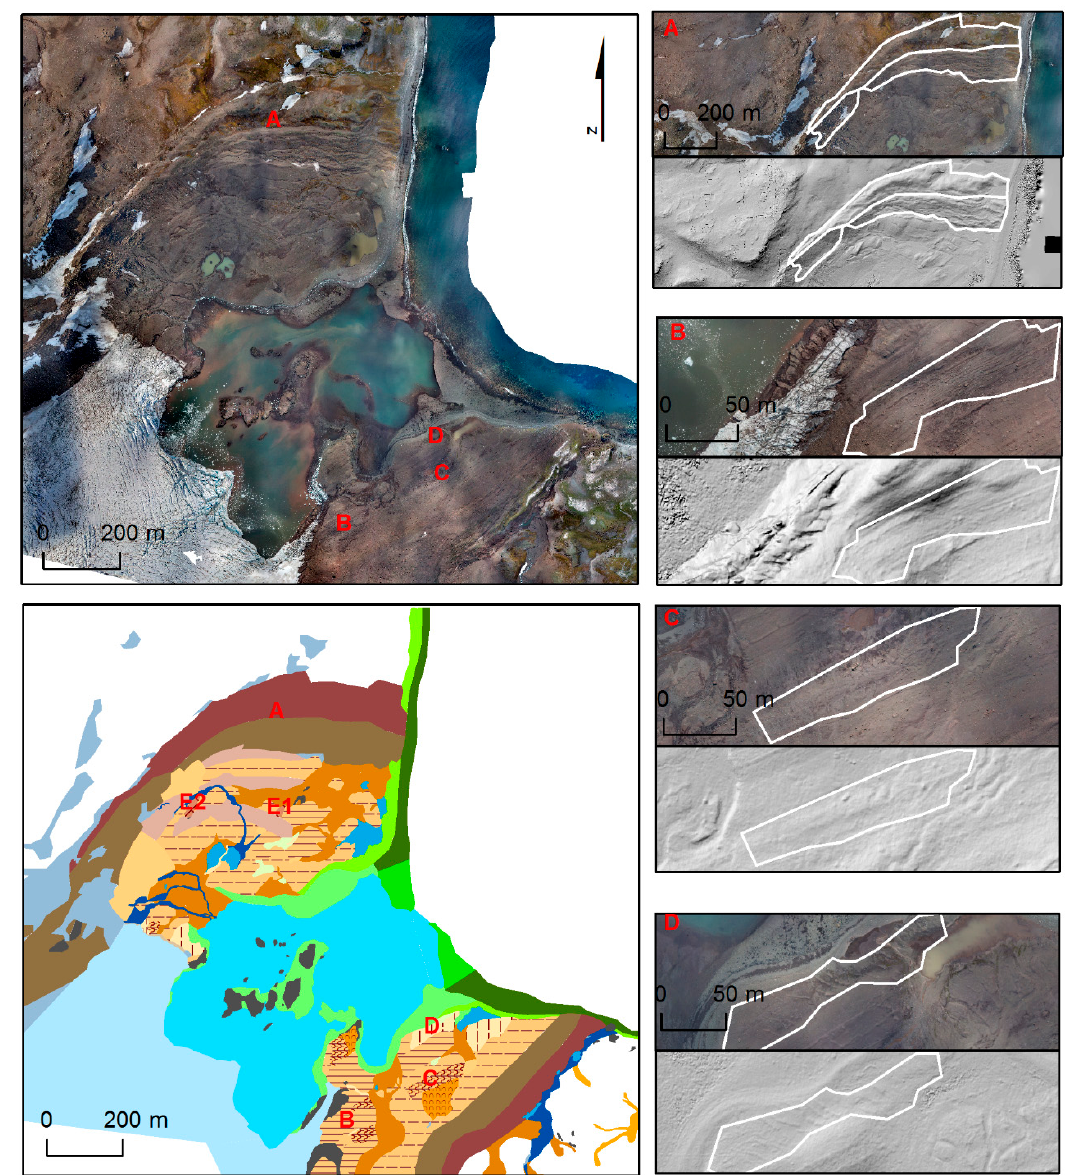
Figure 7. Ecology Glacier foreland: an orthophoto and a detailed geomorphological map (see Figure 6 for legend), and examples of vectorized landform units (white polygons) based on the orthophoto and the Digital Elevation Model; A—old (more distal from the glacier) and young (more proximal) latero-frontal moraine complex; B—fluted moraine, C—fluted moraine with crevasse-fill ridges, D—ground moraine with annual push/stagnation moraines; E1 and E2 mark drumlins, which are discussed in Section 4.3, Figure 11, Table 2.